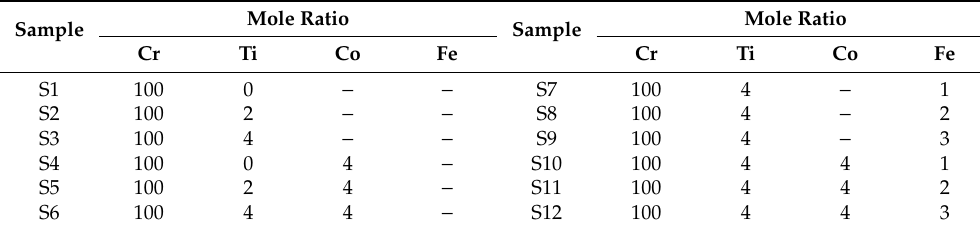
Table 1. Elementary composition of Cr 2 O 3 samples.